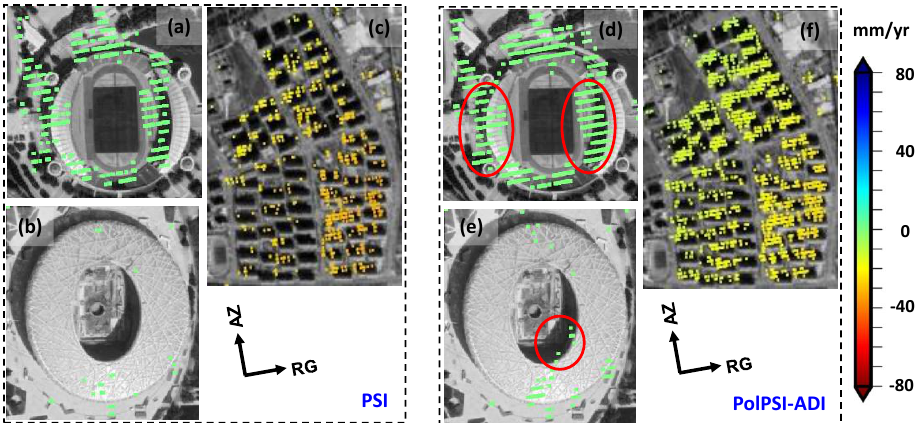
Figure 7. ( a – c ) are the PSI derived ground deformation (in the line-of-sight direction) over the three subareas that are highlighted in Figure 6c,e with white rectangles C, D, and E, respectively. ( d – f ) are the counterparts of ( a – c ) derived by the PolPSI-ADI algorithm.